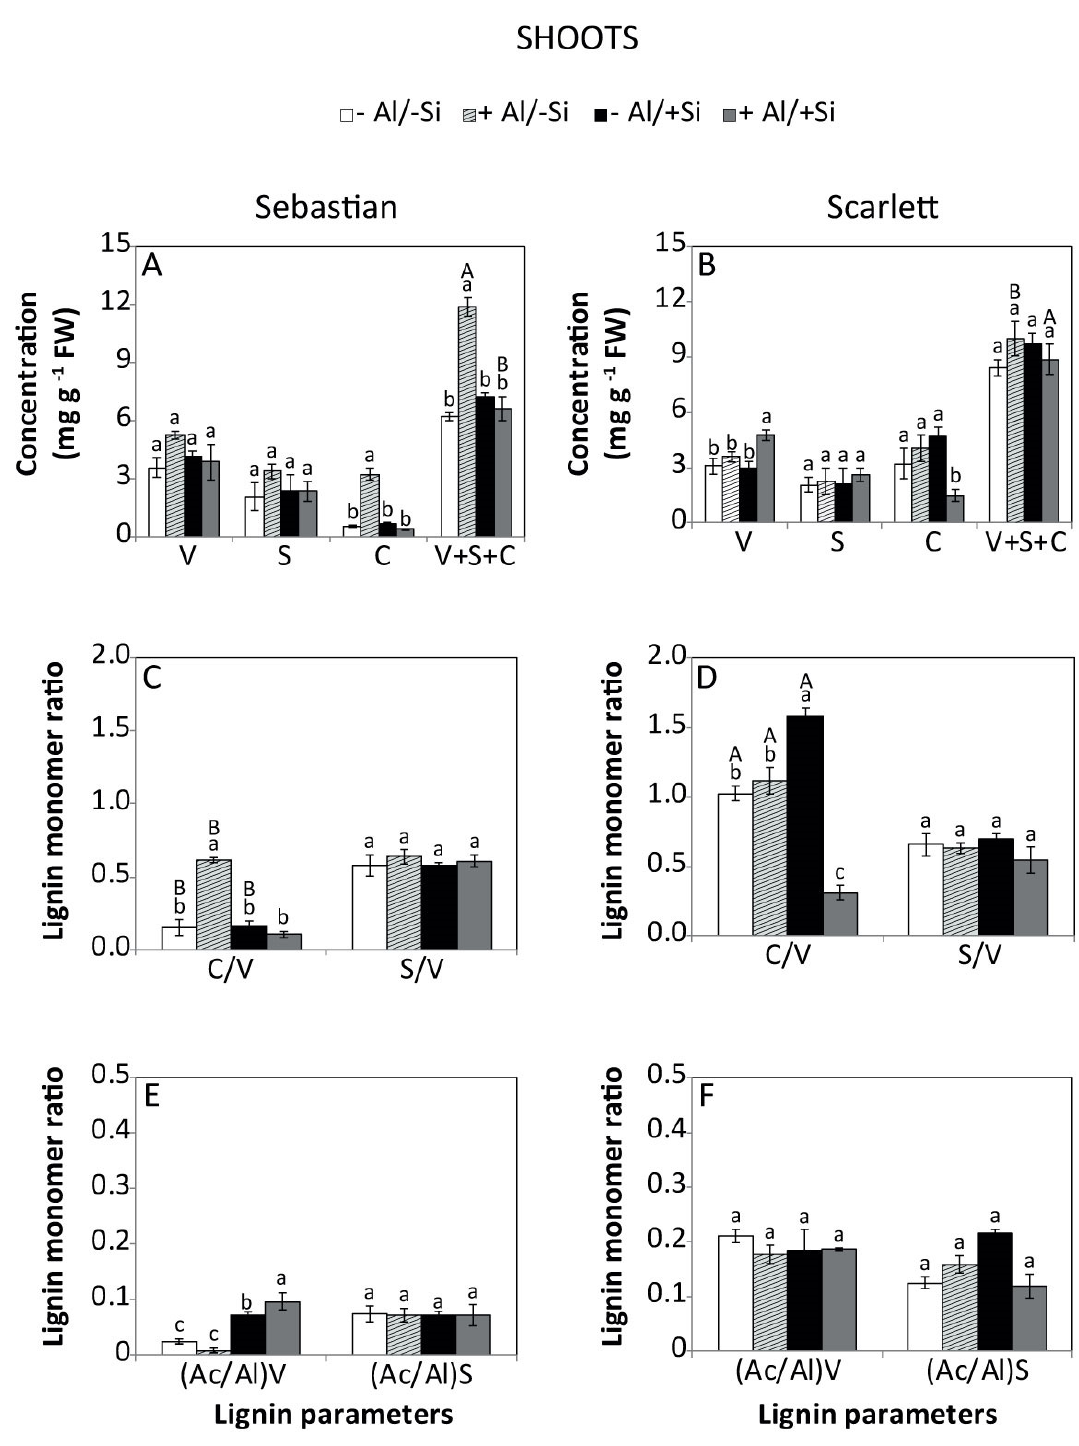
Figure 5. Lignin parameters of the shoots of Sebastian and Scarlett barley cultivars. The main lignin groups ( A / B ), comprising vanillyl [V], syringyl [S] and cinnamyl [C] phenols, and total lignin concentration [S + V + C]; their ratios ( C / D ); and acid to aldehyde ratios ( E / F ) of vanillyl [(Ac/Al)v] and syringyl [(Ac/Al)s]. Treatments were 0 or 0.2 mM Al, combined with 0 or 2 mM Si. Values represent the mean of three replicates per treatment ± SD. Different letters indicate statistically significant differences (p ≤ 0.05) among treatments. The lower case letters represent significant differences between treatments for the same barley cultivar. The upper case letters indicate significant differences between barley cultivars for the same treatment. When uppercase letters do not appear, no significant differences between the same treatment in different cultivars were found.